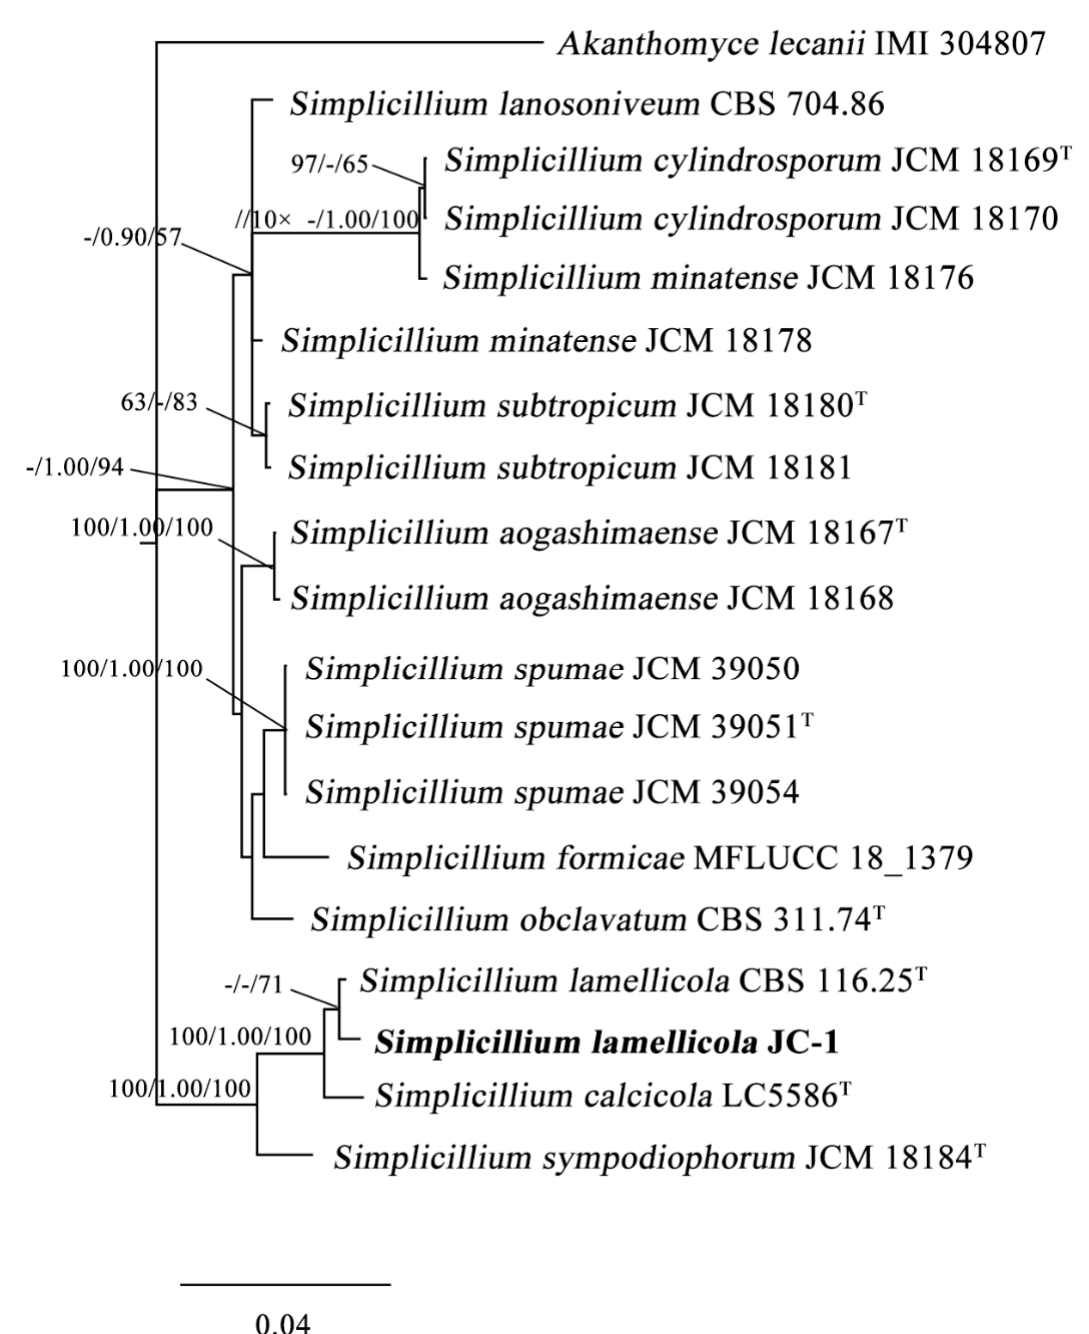
Figure 2. Phylogenetic tree of 19 fungal taxa in the genus Simplicillium and Akanthomyces lecanii (outgroup). The tree was constructed using concatenated sequences of ITS, LSU, SSU, and TEF1 α (see Table 1 for GenBank accession numbers for these loci). RAxML bootstrap support values (ML) higher than 50, Bayesian posterior probability (PP) higher than 0.90, and maximum parsimony (MP) bootstrap support values higher than 50 were shown at the nodes (ML/PP/MP). The scale bar indicates sequence divergence. -, ML < 50 or PP < 0.90. Type strains were labeled with “T” at the top-right